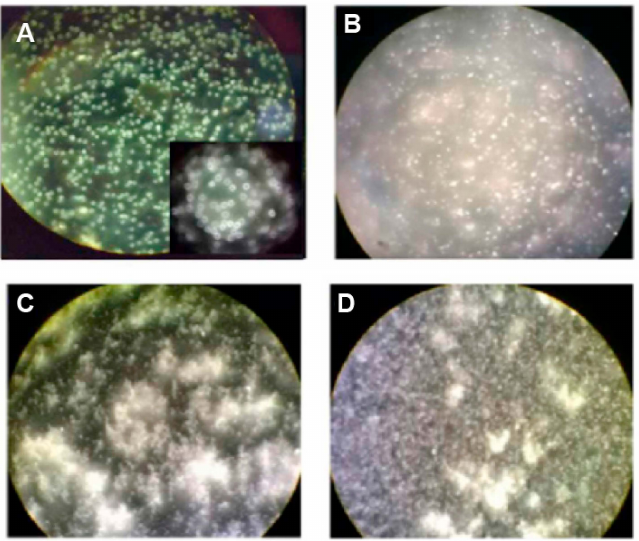
Figure 21. Microscopic images of haemolysis of the erythrocytes (globular morphological destruction and loss of oxygen transport ability) in blood samples in contact with different concentrations of ceramic discs: ( A ) (0 discs), ( B ) (1 disc), ( C ) (2 discs), ( D ) (3 discs) [130].